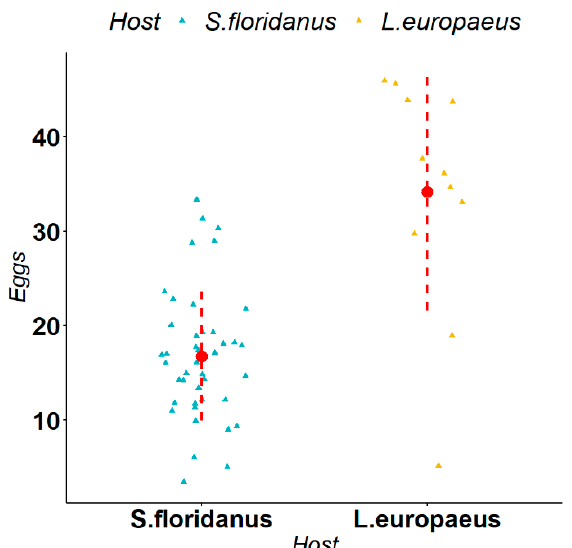
Figure 7. Comparison of female fertility (i.e., in utero count of the number of eggs) of Trichostrongylus affinis in Lepus europaeus and Sylvilagus floridanus . The triangles represent the single observations, the red dots represent the average values, while the red dashed lines represent the standard deviation.